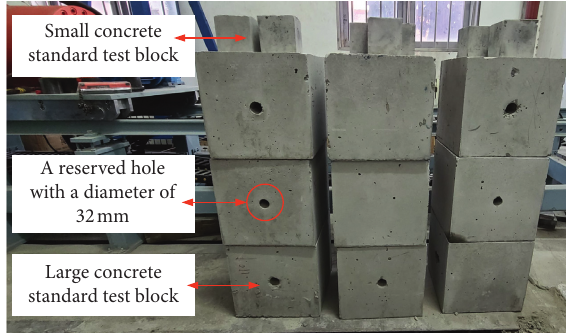
Figure 3: Part of the test blocks.